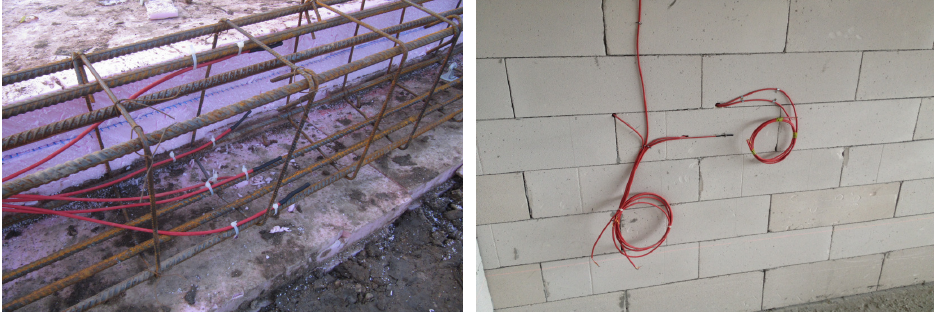
Fig. 11. Ground floor exterior beam sensors Fig. 12. Exterior wall